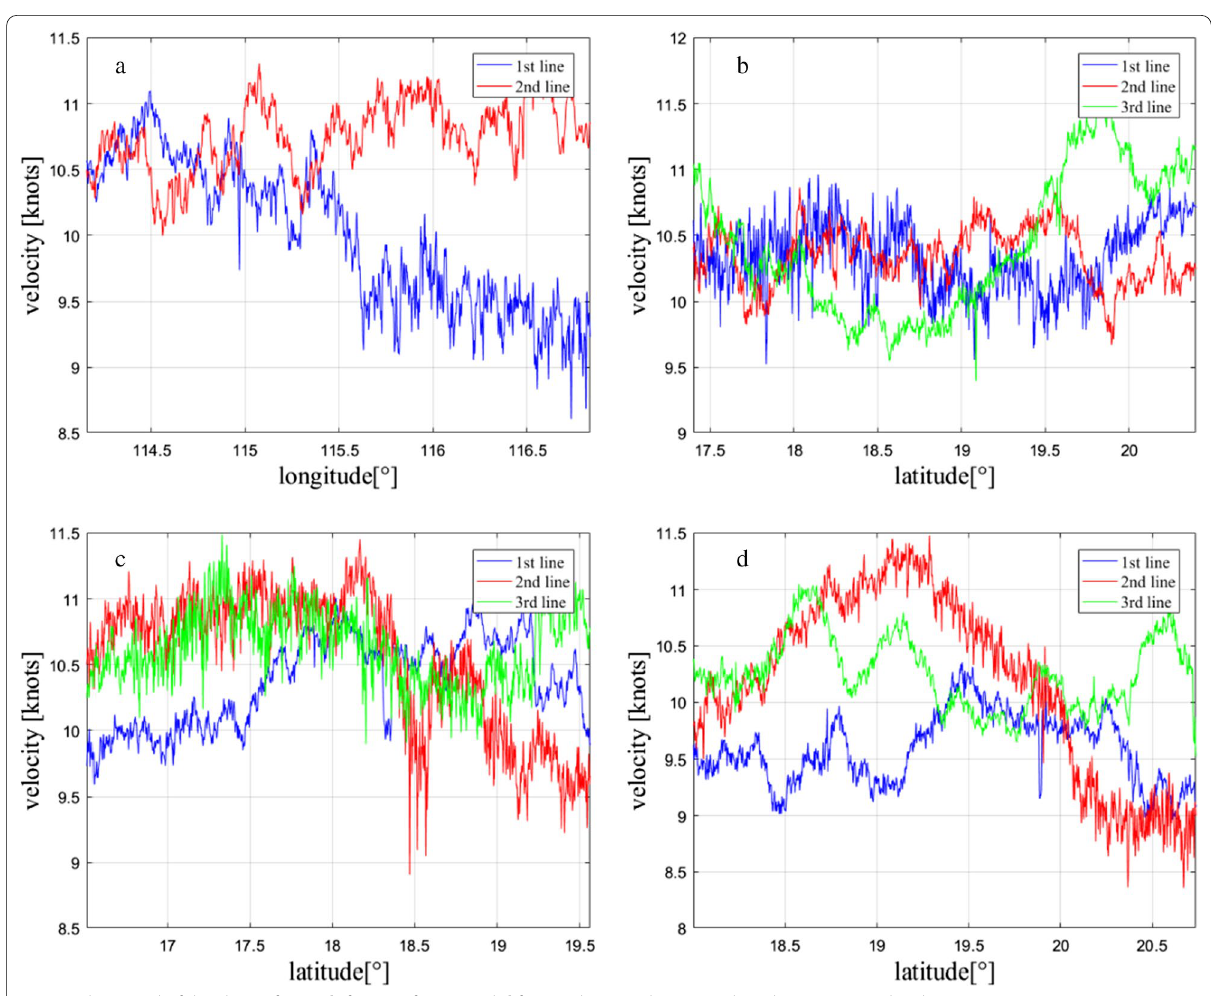
Fig. 6 The speed of the ship: a for H1, b for S1, c for X1, and d for X2. The speed is somewhere between 9 and 11 knots